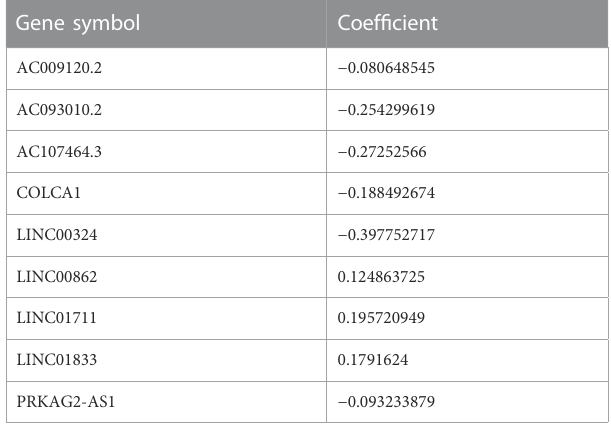
TABLE 2 Prognostic LncRNAs obtained from LASSO Cox regression